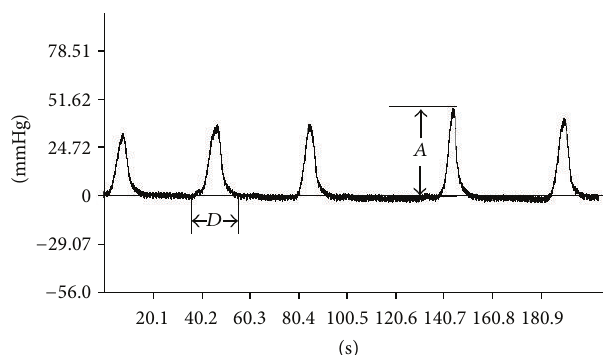
Figure 2: Representative gastric contraction wave in rat, showing the duration (𝐷) and amplitude